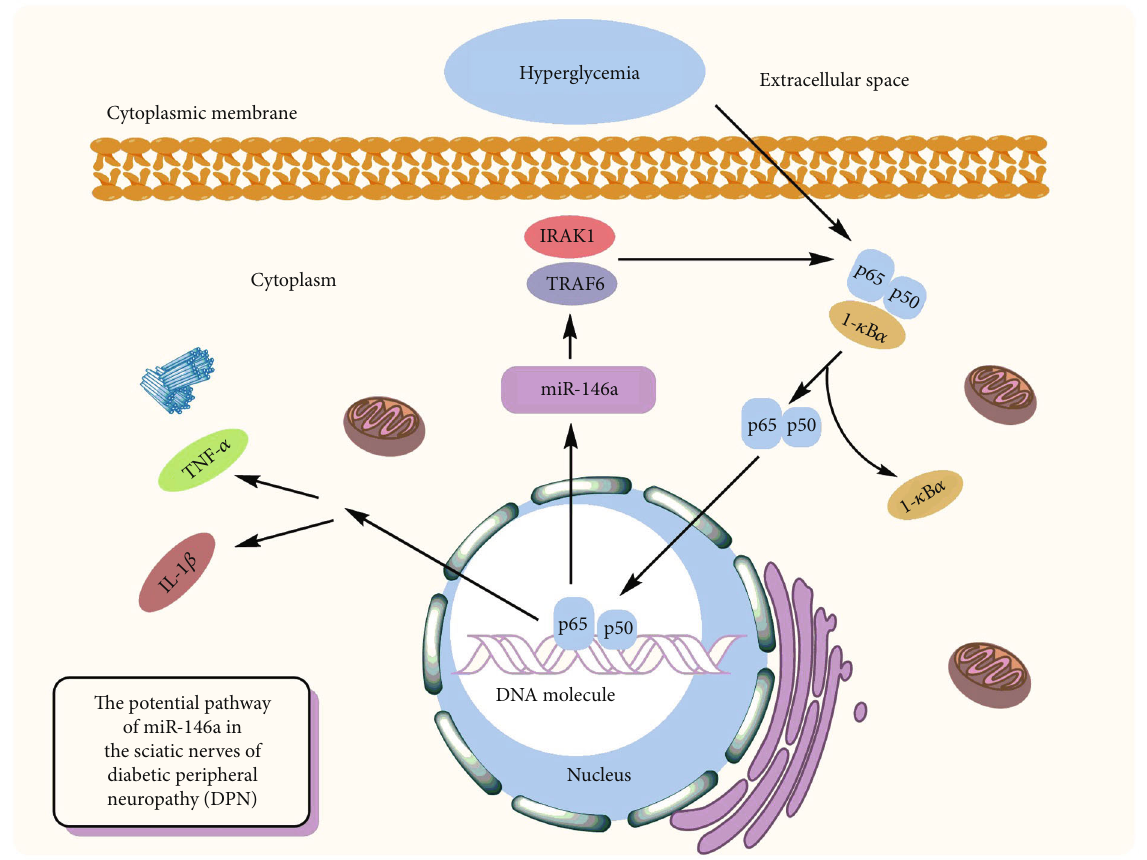
Figure 4: Association of miR-146a with diabetic